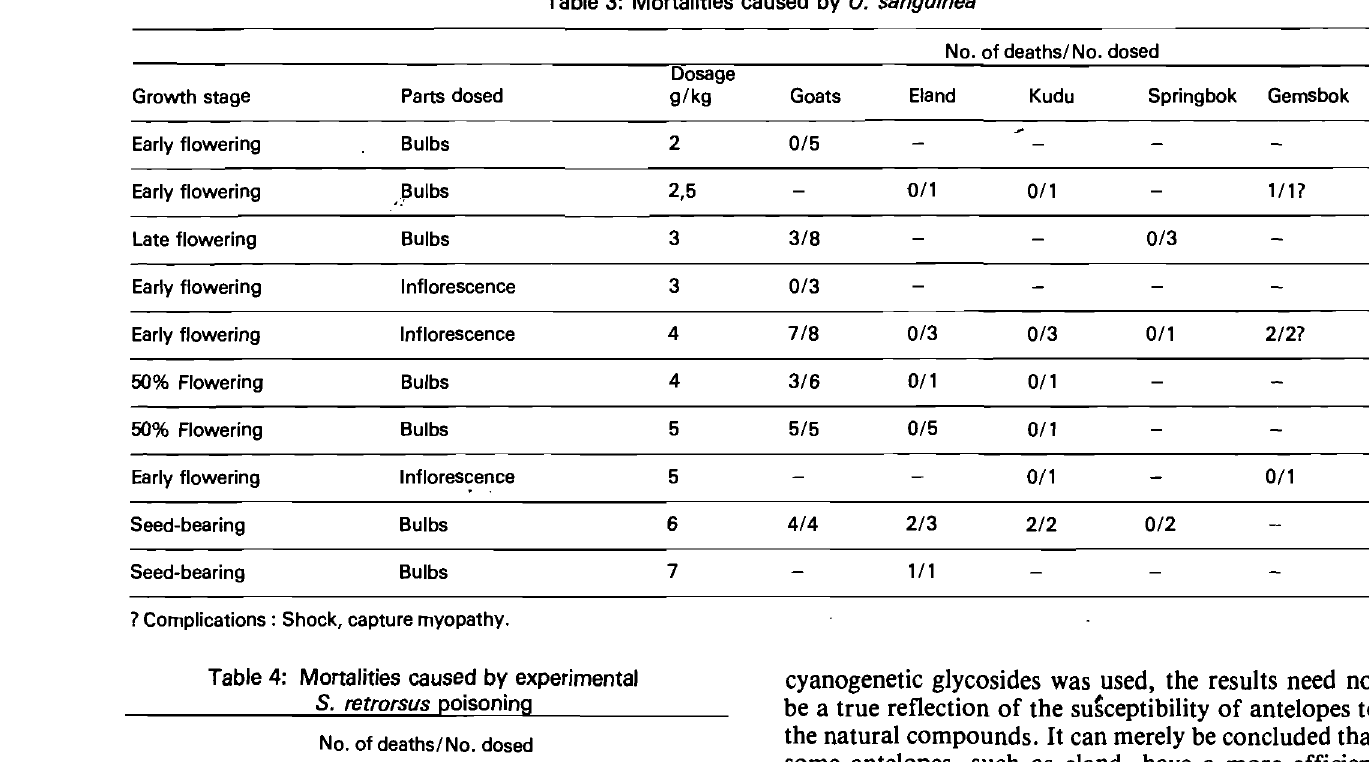
Table 4: Mortalities caused by